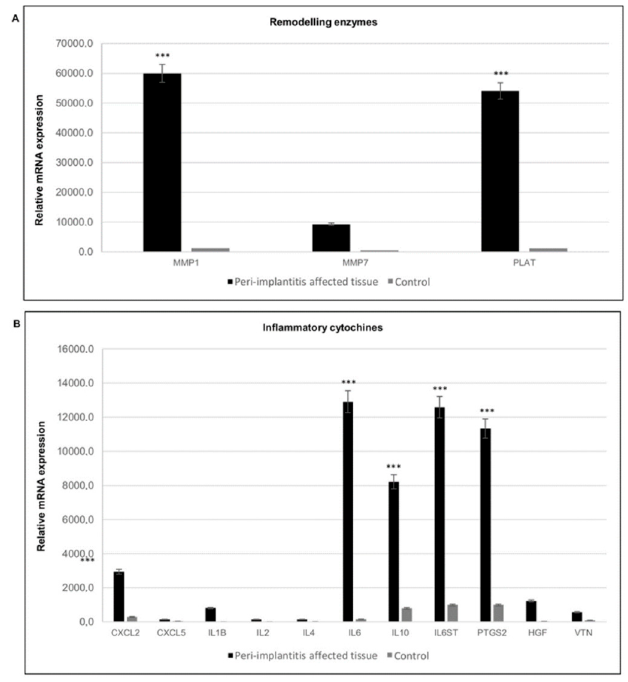
Figure 7. Gene expression profile of genes involved in extracellular matrix remodeling and of inflammatory cytokines. ( A ) Gene expression of matrix metallopeptidases in peri-implantitis a ff ected tissues (black) and healthy tissue (grey). ( B ) Gene expression of inflammatory cytokines and chemokines metallopeptidases in peri-implantitis a ff ected tissues (black), and healthy tissue (grey). The bars are related to the increase / decrease related to the value obtained from the control (peri-implant healthy tissue). Black bars peri-implantitis a ff ected tissues, grey bars control. T-tests were used to determine significant di ff erences ( p < 0.05). * p < 0.05; ** p < 0.01; *** p <